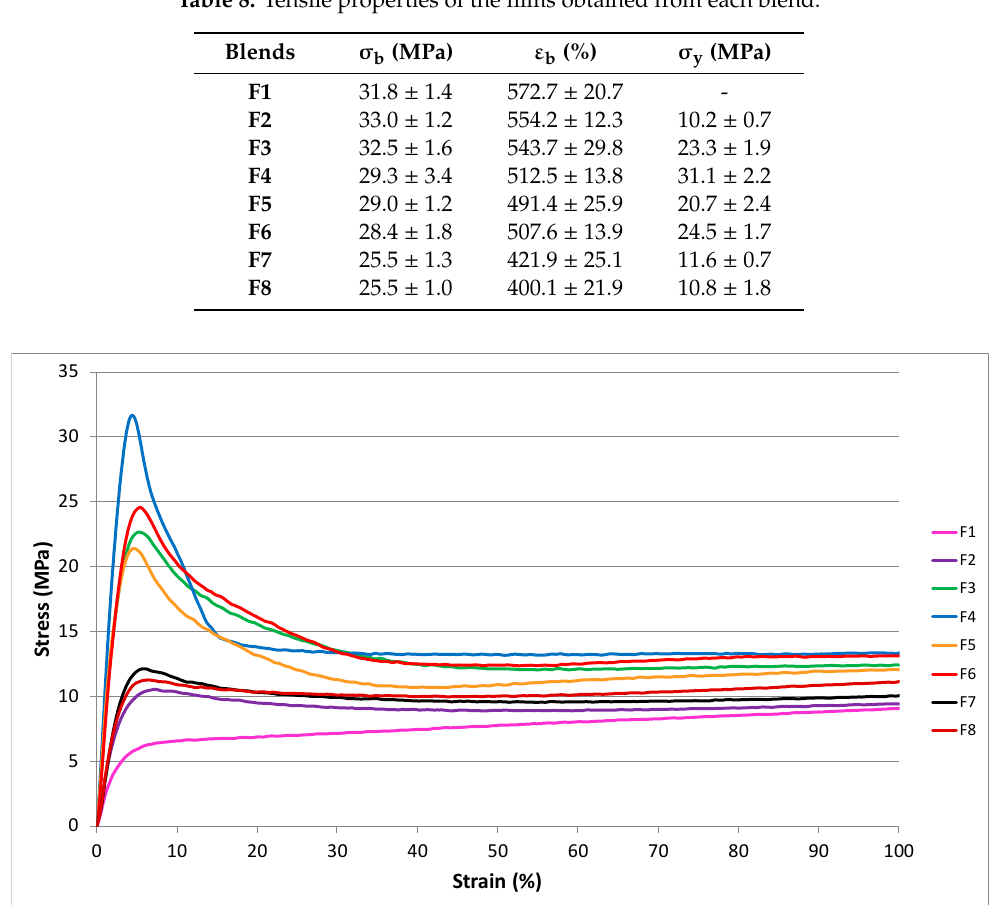
Figure 8. First part of the stress-strain curves for the formulations examined.